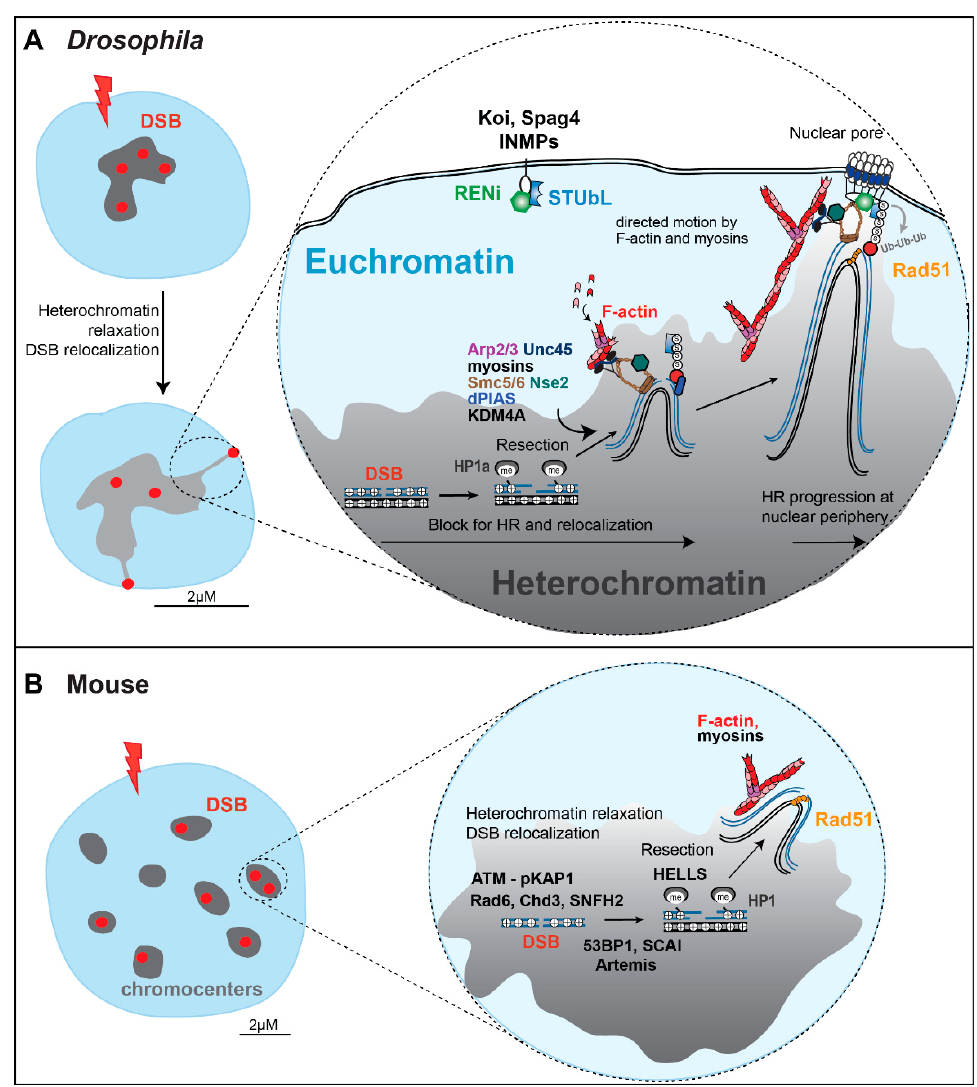
Figure 4. Heterochromatin repair mechanisms in Drosophila and mouse cells. ( A , B ) Molecular mechanisms mediating HR repair in Drosophila and mouse cells, with some of the main factors regulating DSB resection, chromatin remodeling, heterochromatin relaxation, relocalization of repair sites, and HR progression (also reviewed in [6]). S: SUMOylation. Ub: Ubiquitinaltion. INMP: Inner nuclear membrane proteins. See details in the text.